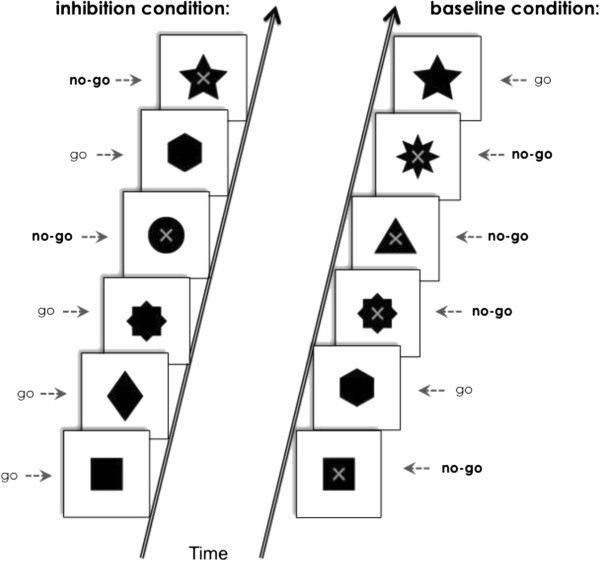
Illustration of the go/no-go paradigm employed in this study, with the inhibition condition on the left (consisting of 33% no-go trials) and the baseline condition on the right (consisting of 67% no-go trials). The ‘Go’ stimuli, seen as solid black shapes, and the ‘no-go’ stimuli, seen as black shapes with an X superimposed on them, are labelled.